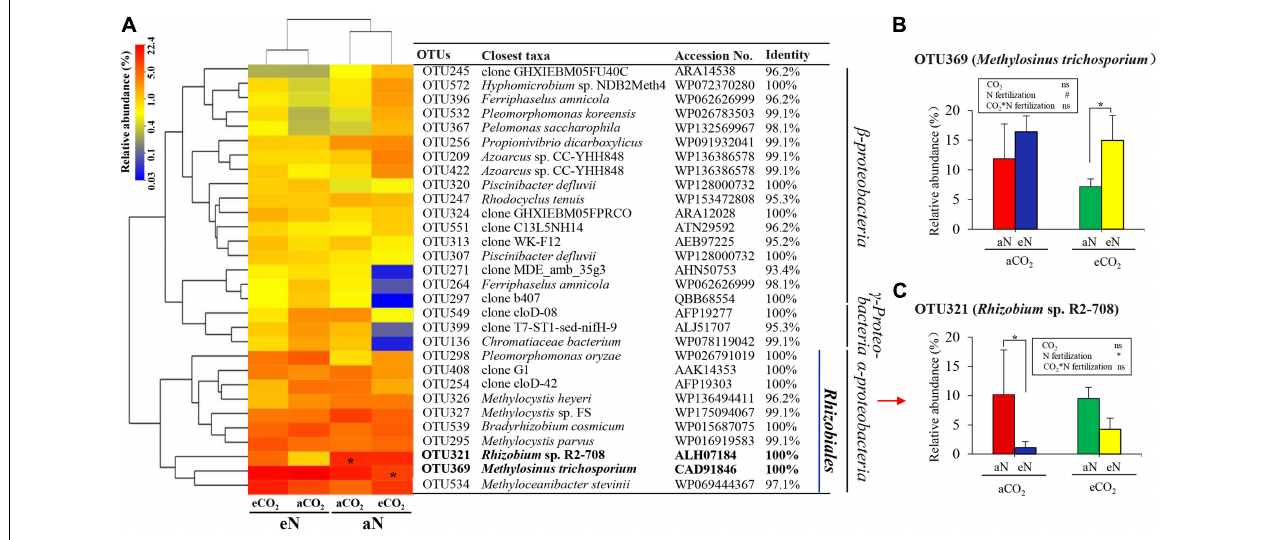
FIGURE 5 | Heatmap analysis of the similarities and differences of N 2 -fixing bacteria of rice roots at the heading stage under elevated CO 2 and nitrogen fertilization treatments from the top 30 OTUs (A) . The color intensity in each cell shows the relative abundance of a genus/species in a sample. Bold typeface indicates the main OTUs (A) . Interactive effects of elevated CO 2 and nitrogen fertilization on the relative abundance of the two main OTUs (B,C) . aCO 2 , ambient CO 2 ; eCO 2 , elevated atmospheric CO 2 . aN, no N fertilization; eN, elevated N fertilization. Considering the split-plot design, the statistics, the analysis of variance were derived using linear mixed-effects model procedure to test the effect of elevated CO 2 , N fertilization, and their interactions on the relative abundance of the main OTUs at the same growth stage. Multiple comparison were further used to determine which groups were significantly different with Duncan test. ∗ p ≤ 0.05, # 0.05 < p ≤ 0.10, ns p > 0.10. TABLE 1 | Relative abundance (%) of methylotrophs at the genus level in the total N 2 -fixing bacterial communities of rice roots at the heading stage. Ambient CO 2 Elevated atmospheric CO 2 Closest taxa a aN